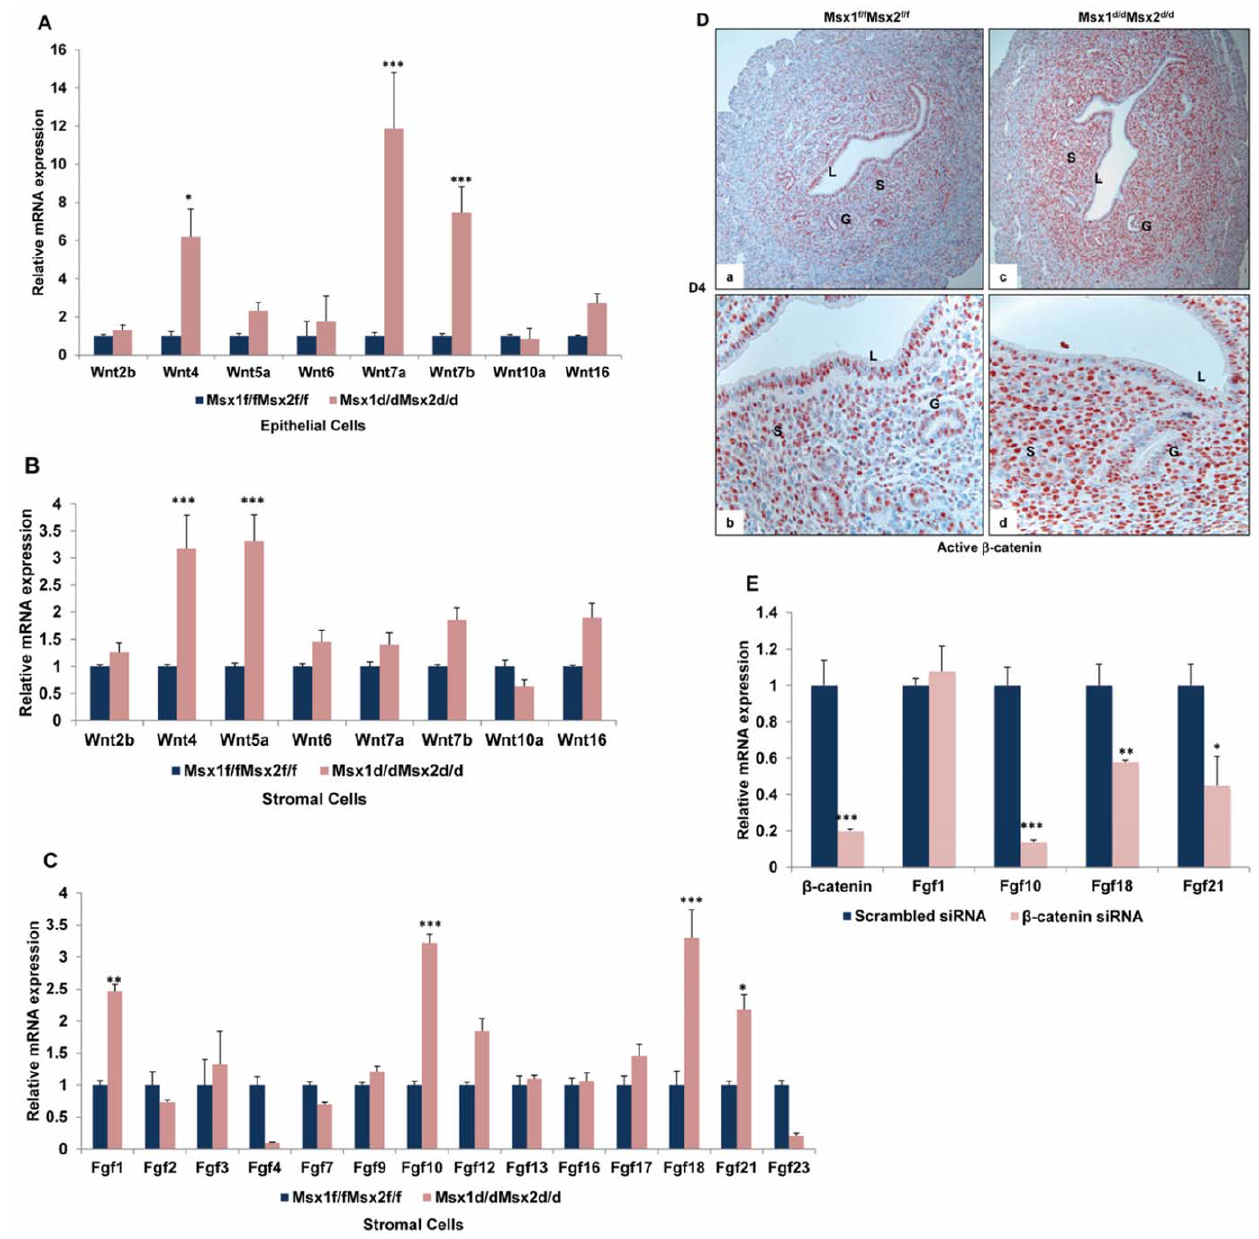
Figure 5. Wnt/ b -catenin signaling controls FGF synthesis in uterine stromal cells. A. Real-time PCR was performed to analyze the expression of Wnt ligands in uterine epithelial cells of Msx1 f/f Msx2 f/f and Msx1 d/d Msx2 d/d mice on day 4 of pregnancy. The level of Ck18 was used as internal control to normalize gene expression. The data are represented as the mean fold induction 6 SEM, *p , 0.01, ***p , 0.0001. B. Real-time PCR was performed to analyze the expression of Wnt ligands in uterine stromal cells of Msx1 f/f Msx2 f/f and Msx1 d/d Msx2 d/d mice on day 4 of pregnancy. C. Real-time PCR was performed to analyze the expression of Fgf family members in uterine stromal cells of Msx1 f/f Msx2 f/f and Msx1 d/d Msx2 d/d mice on day 4 of pregnancy. The level of Rplp0 was used as internal control to normalize gene expression. The data are represented as the mean fold induction 6 SEM,*p , 0.01, **p , 0.001, ***p , 0.0001. D. The level of active b -catenininuterine sections of Msx1 f/f Msx2 f/f (leftpanel) and Msx1 d/d Msx2 d/d (right panel) mice on day 4 of pregnancy was analyzed by IHC. (Magnification: a and c: 10 6 , b and d: 40 6 ) E. Primary stromal cells were isolated from uteri of Msx1 d/d Msx2 d/d mice on day 3 of pregnancy and transfected with siRNA targeted to the b -catenin mRNA. Total RNA was isolated 24 h after transfection to analyze the expression of Fgf family members by Real-time PCR. The level of Rplp0 was used as an internal control to normalize gene expression. The data are represented as the mean fold induction 6 SEM, *p , 0.01, **p , 0.001, ***p , 0.0001.